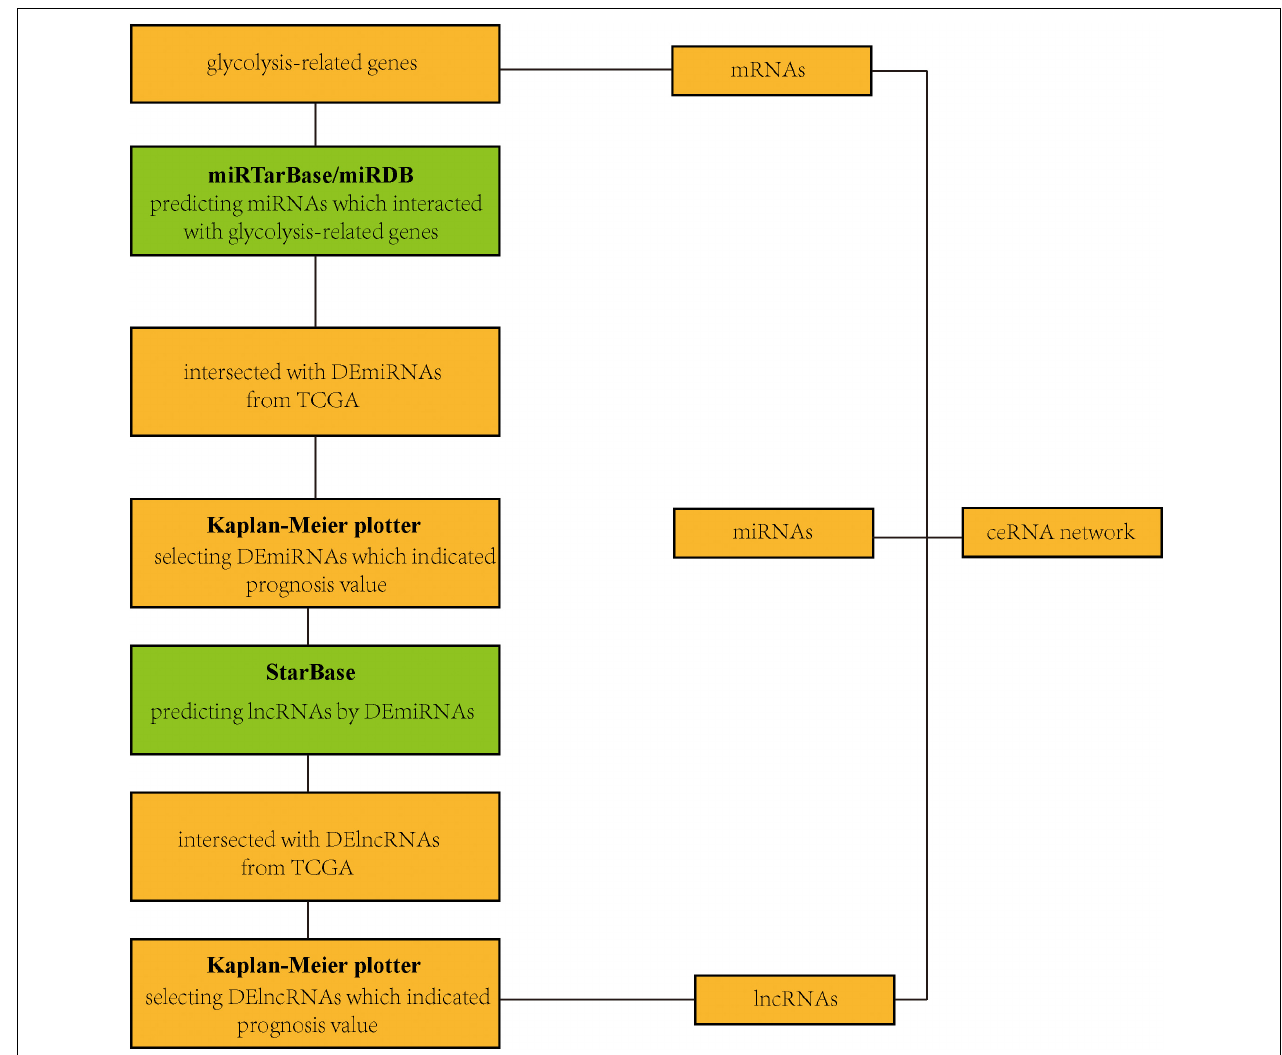
FIGURE 6 | Construction of a ceRNA network. A flow diagram of a 43-glycolysis-related-gene ceRNA network in LUAD. ceRNA, competing endogenous RNA; LUAD, lung adenocarcinoma; DEmiRNAs, differentially expressed miRNAs; TCGA, The Cancer Genome Atlas; DElncRNAs, differentially expressed